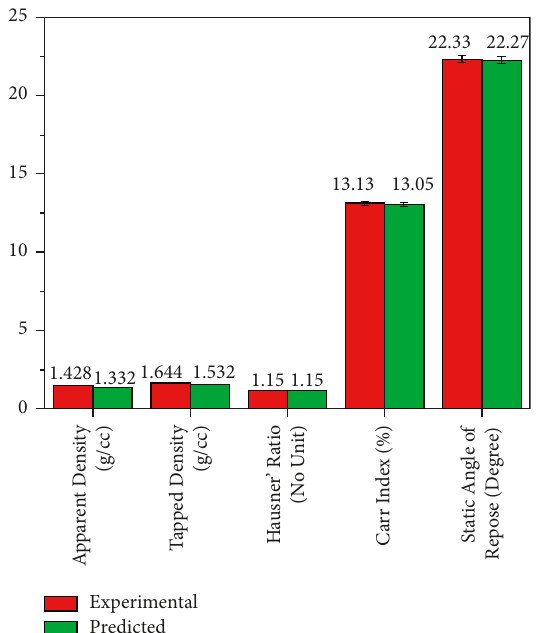
Figure 10: Comparison between experimental and predicted values for optimum